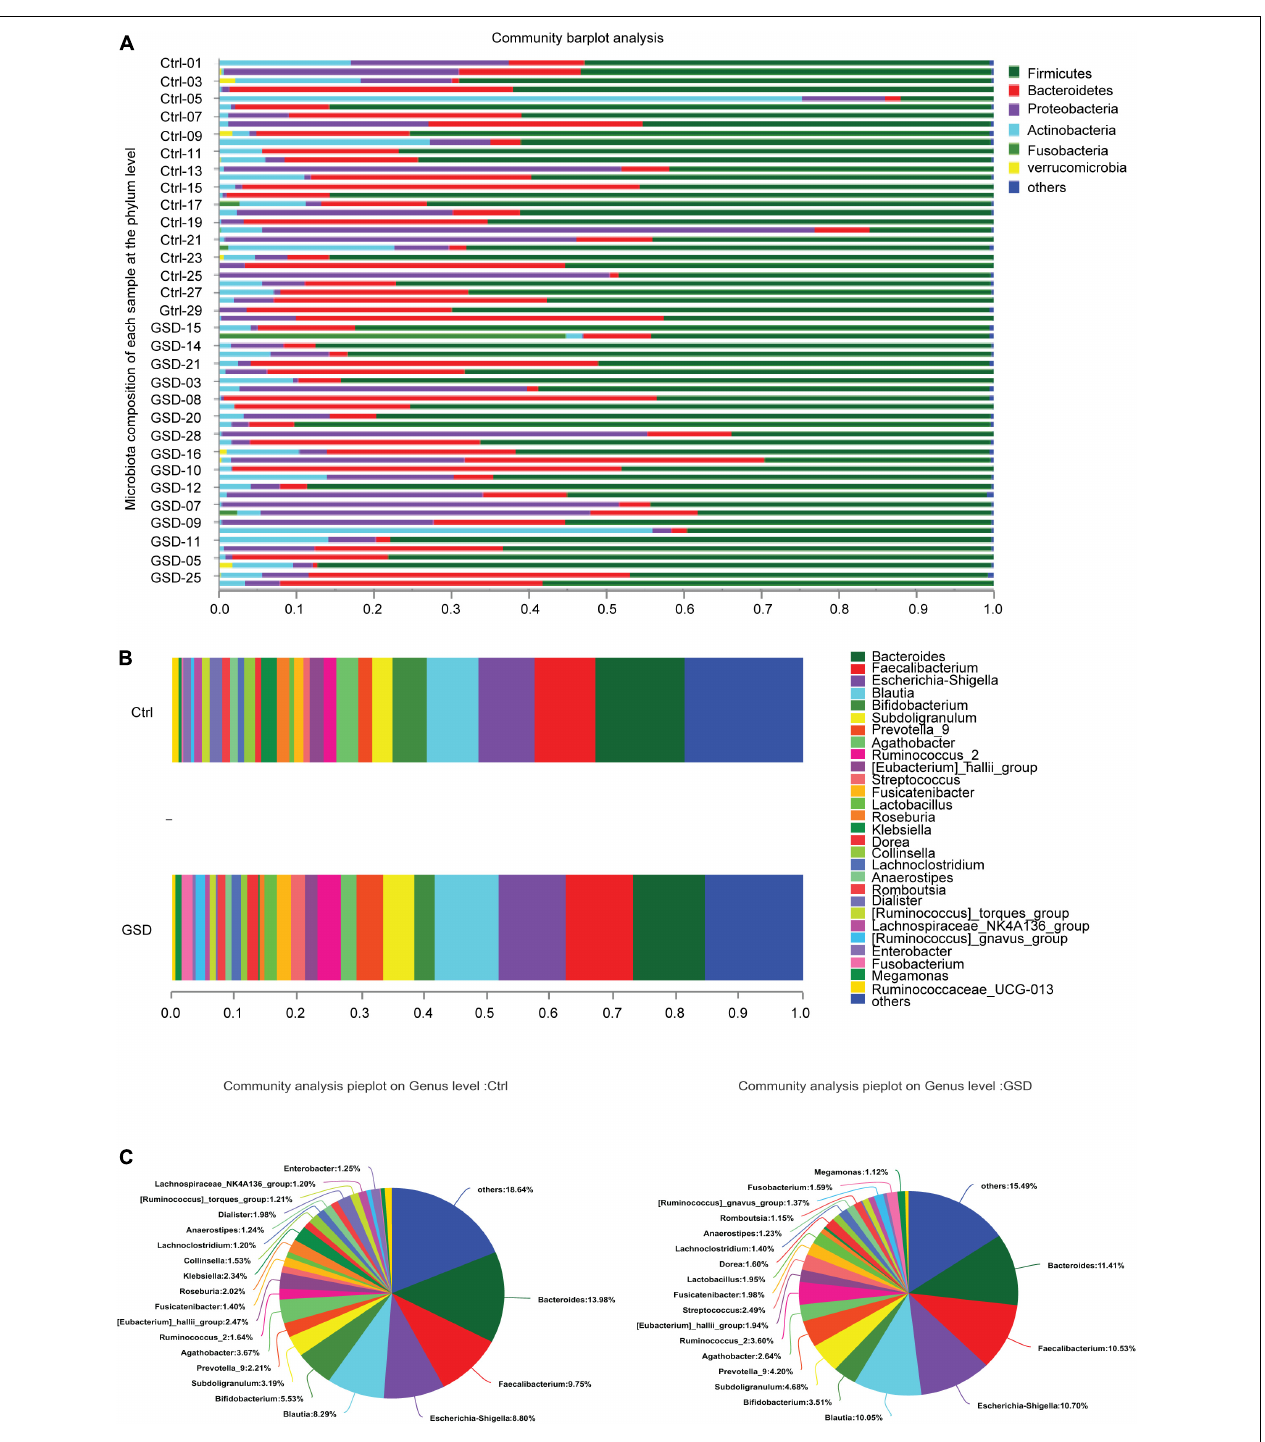
FIGURE 2 | The microbiota composition of each sample at the genus and phylum level. (A) Microbiota composition of each sample at the phylum level. (B,C) The proportion of gut microbiota abundance in two groups (genus level). GSD, asymptomatic gallstone group; Ctrl, control group. * P < 0.05; ** P < 0.01.